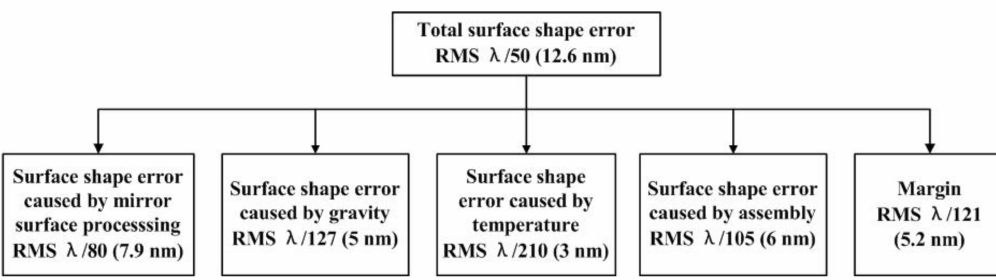
Figure 1. Surface shape error allocation of the mirror component.